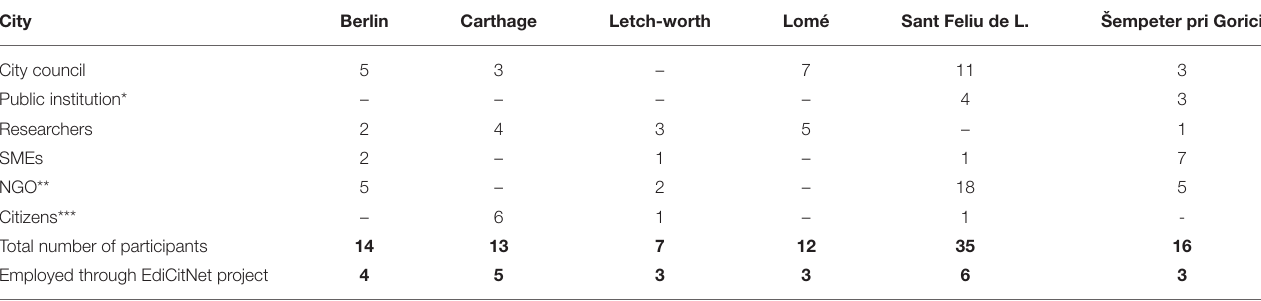
TABLE 1 | Number of participants of the participatory planing process as initally planned ( * Schools, supramunicipal managerial entity, ** incl. public, community, network, association, cooperative, foundation, *** not represented in other category) and employed city-team members through the EdiCitNet project. City Berlin Carthage Letch-worth Lomé Sant Feliu de L. Šempeter pri